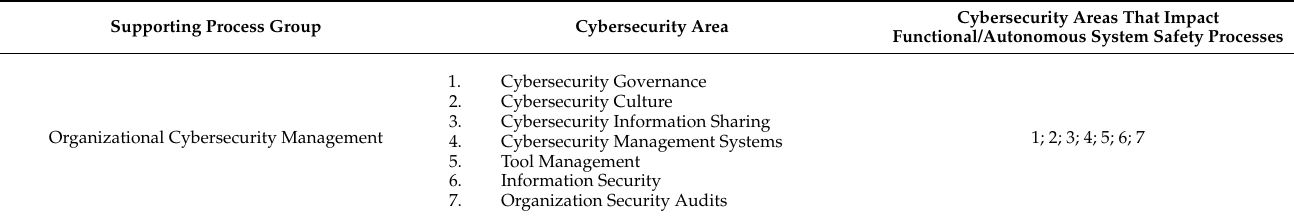
Table 4. The impact of cybersecurity on the supporting process group for product development. Supporting Process